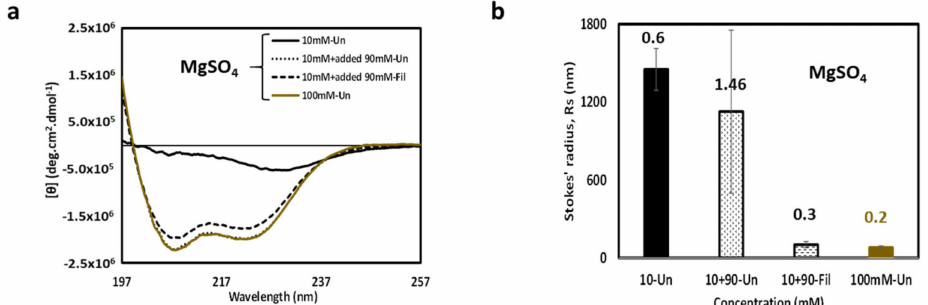
Figure 6. CD spectra and DLS analysis after reintroduction of salt. ( a ) 10 mM MgSO 4 sample (solid black line) shows signs of large species formation (loss of signal); This signal loss can be eliminated by increasing the MgSO 4 concentration to 100 mM (dotted black line); the resulting spectrum overlaps nearly perfectly with that of the original 100 mM sample (solid brown line). The dashed black line represents the slightly reduced CD spectrum of the added MgSO 4 sample after filtration to remove any remaining large particles. ( b ) Corresponding DLS of samples from panel ( a ). Error bars represent the standard deviation in Stokes’ radii from multiple runs, and the number above each bar represents the average polydispersity value for these